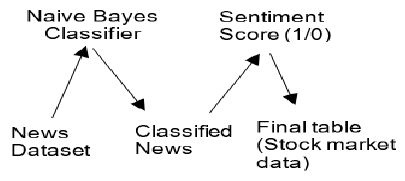
Figure 5 . Flow of Data from sentiment analysis to